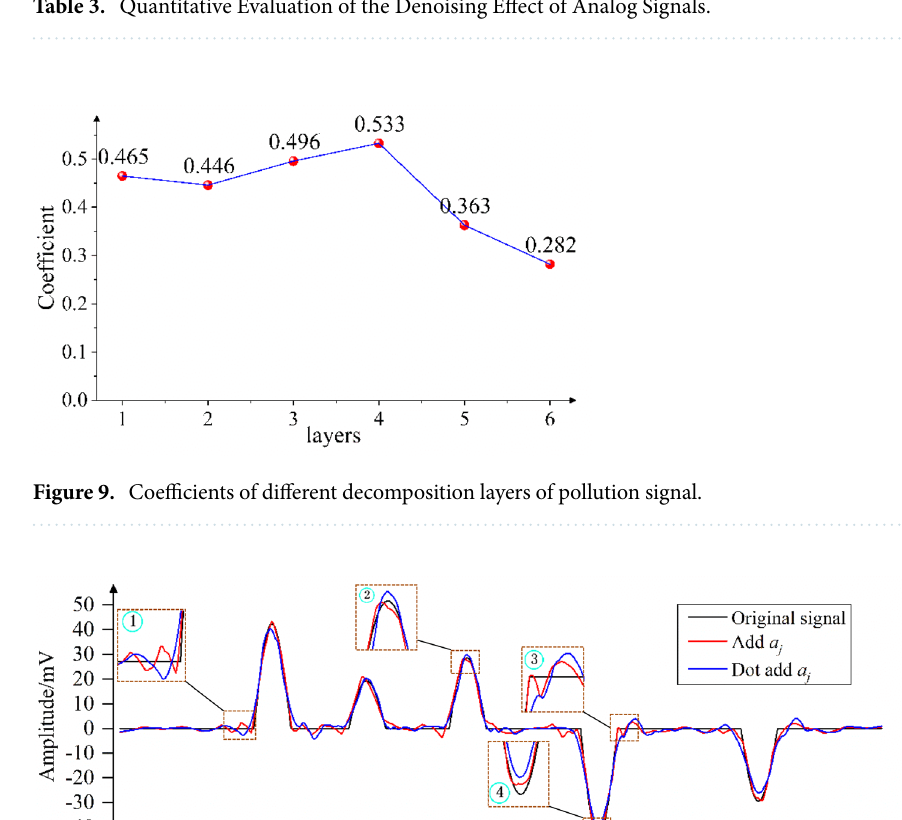
Table 3. Quantitative Evaluation of the Denoising Effect of Analog Signals.